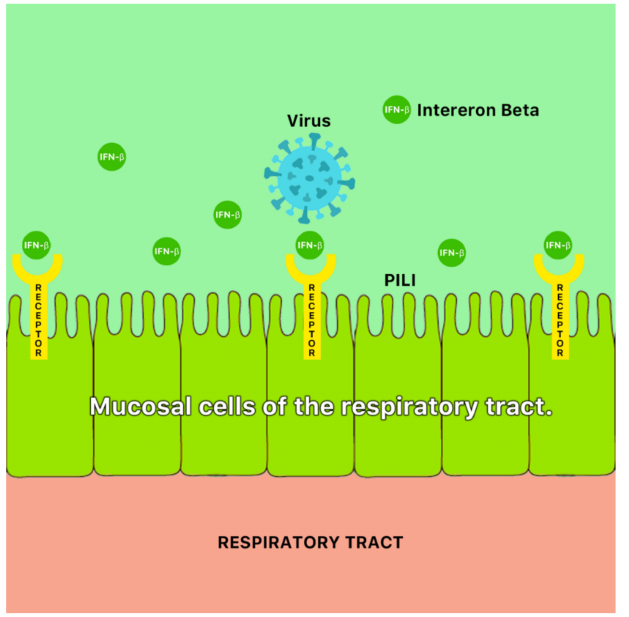
Figure 9. A possible antiviral mechanism of ginger ( Zingiber officinale Roscoe). It is possible that ginger blocks viral attachment and internalization via stimulation of mucosal cells of the respiratory tract to secrete interferon- β (IFN- β )